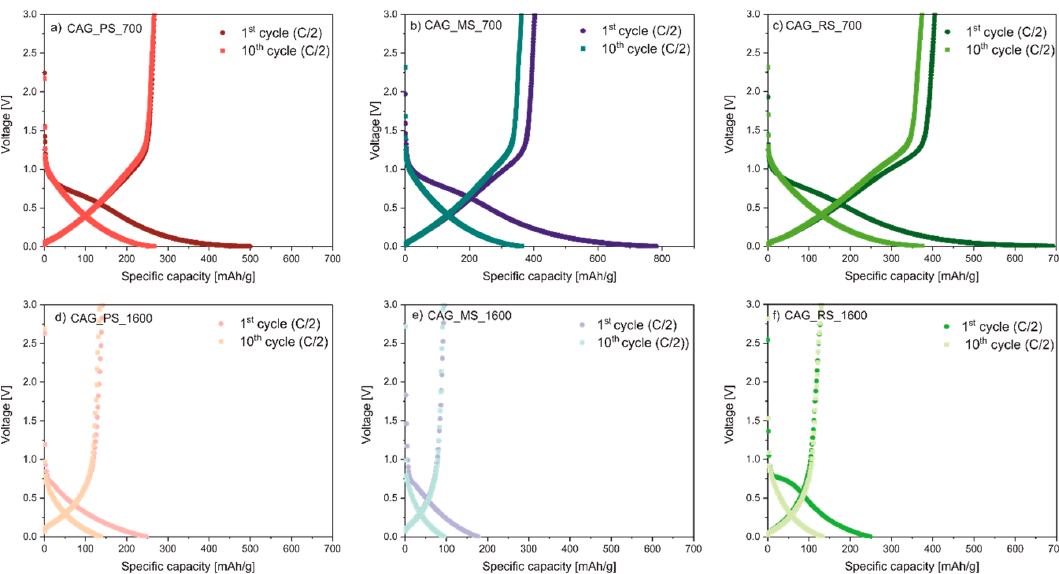
Figure 4. Charge-discharge voltage profiles for the first and tenth cycles of ( a ) CAG_PS_700 ( b ) CAG_MS_700, and ( c ) CAG_RS_700 vs. ( d ) CAG_PS_1600, ( e ) CAG_MS_1600, and ( f ) CAG_RS_1600 at C / 2 current rate.